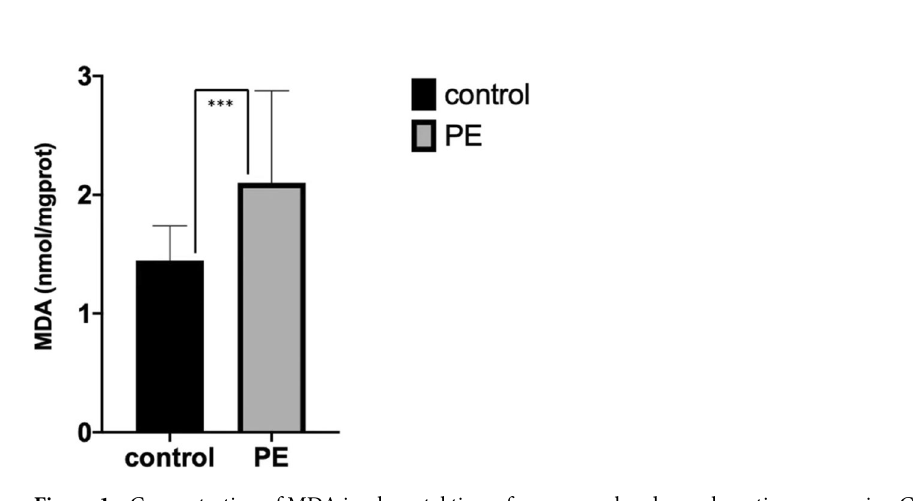
Figure 1. Concentration of MDA in placental tissue from normal and preeclamptic pregnancies. Concentration of MDA was significantly increased in PE group (P < 0.001). Comparison between two groups was conducted by the independent sample